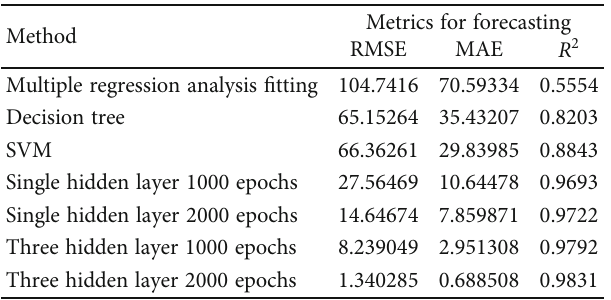
Figure 10: Plot of MD of core clastic sieve analysis and training fi tted grain size rendezvous for well X1. Table 4: Analysis of the training results of the MD machine learning method for well